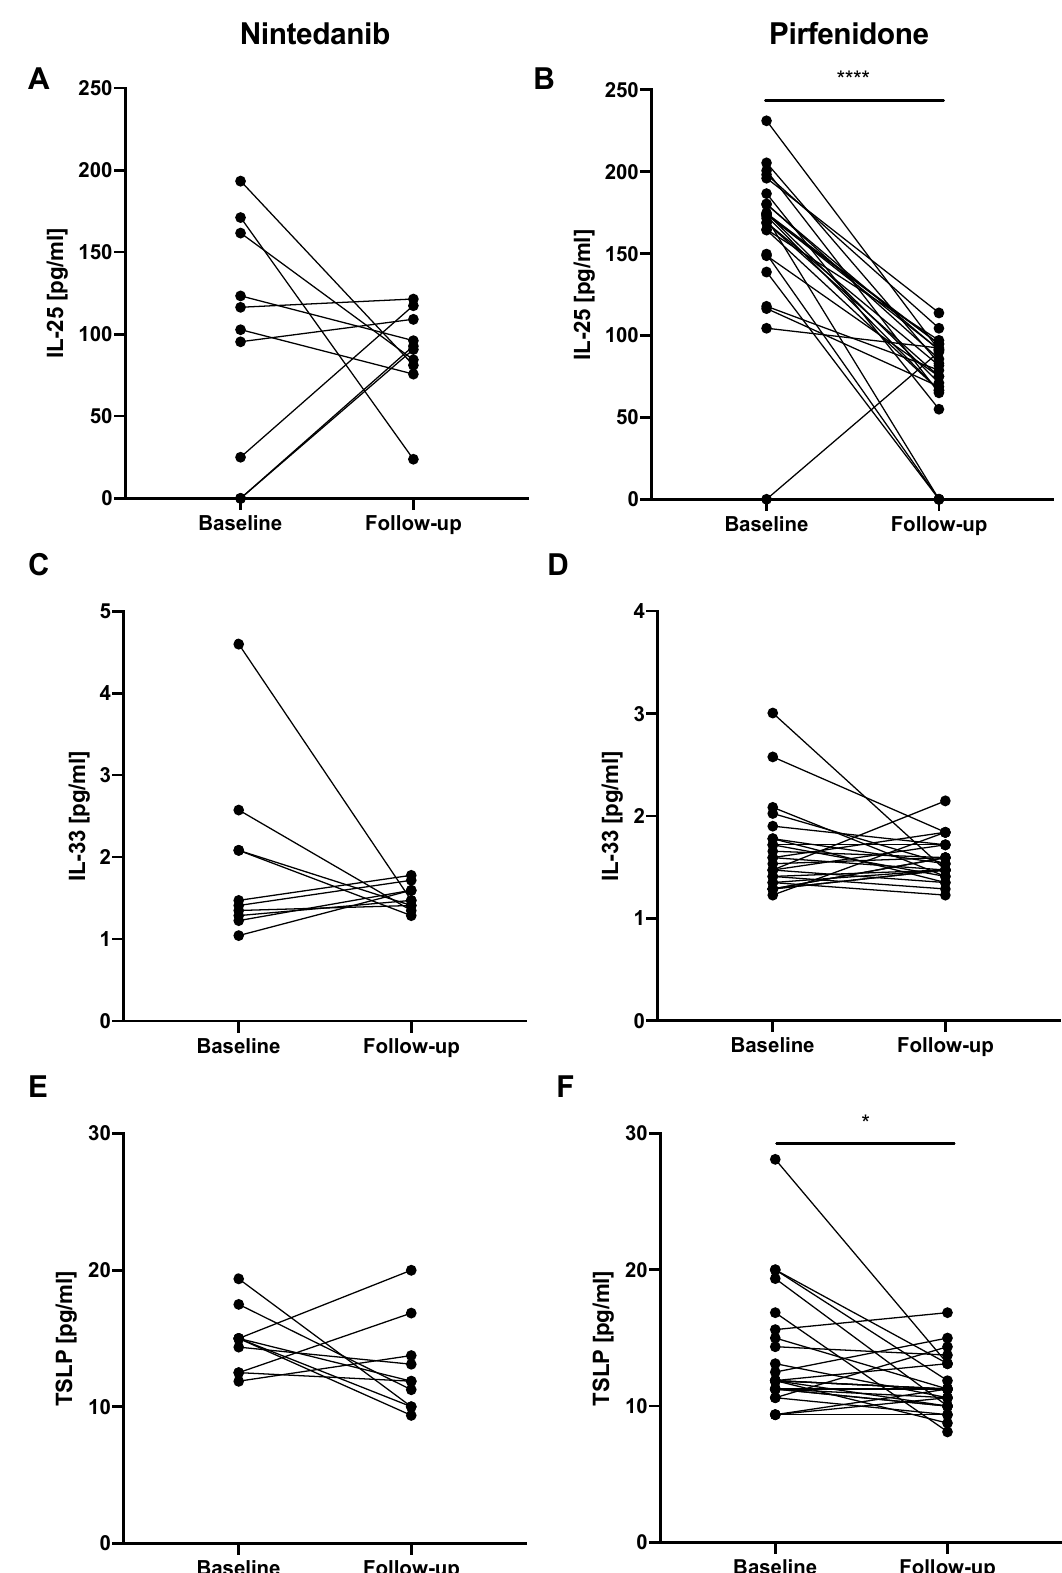
Figure 6. Changes in the epithelial alarmin levels in the EBC of patients with IPF before and after 12 months of antifibrotic therapy according to the antifibrotic agent used. Notes: Panels showing: ( A ) change in IL-25 EBC level in IPF patients treated with nintedanib; ( B ) change in IL-25 EBC level in IPF